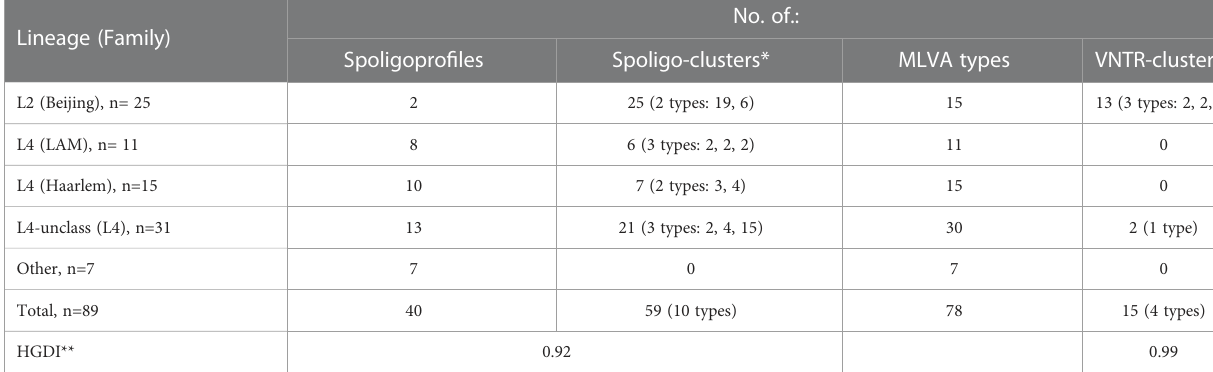
TABLE 2 Spoligotyping and VNTR-typing